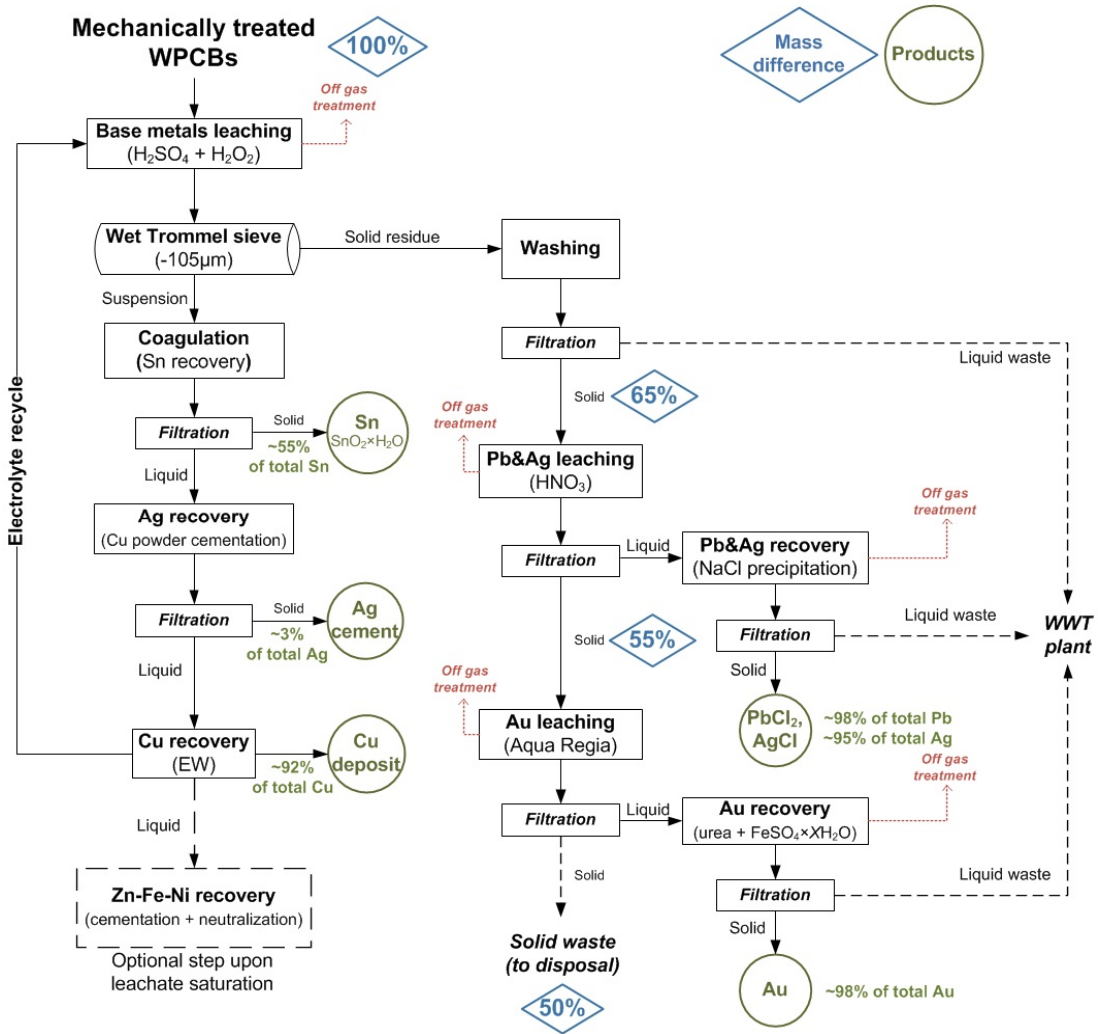
Figure 10. Process flow sheet for integral multi-step hydrometallurgical method for selective base and precious metals recovery from WPCBs.